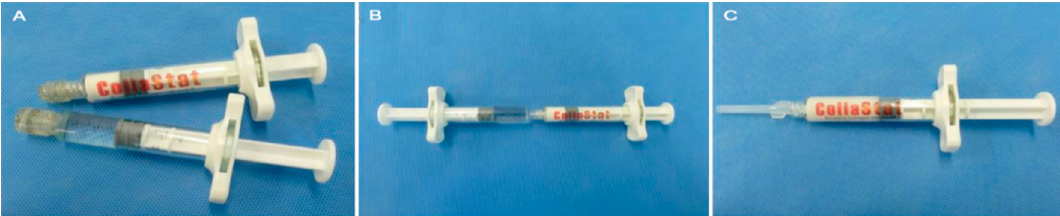
Figure 1. Preparation of CollaStat ® . ( A ) CollaStat consists of two syringes: one for collagen granules and thrombin and the other for CaCl 2 solution. ( B ) CollaStat ® can be easily prepared by connecting the two syringes and mixing them. ( C ) After mixing and detaching the CaCl 2 syringe, CollaStat is ready for use by connecting the enclosed application tip.